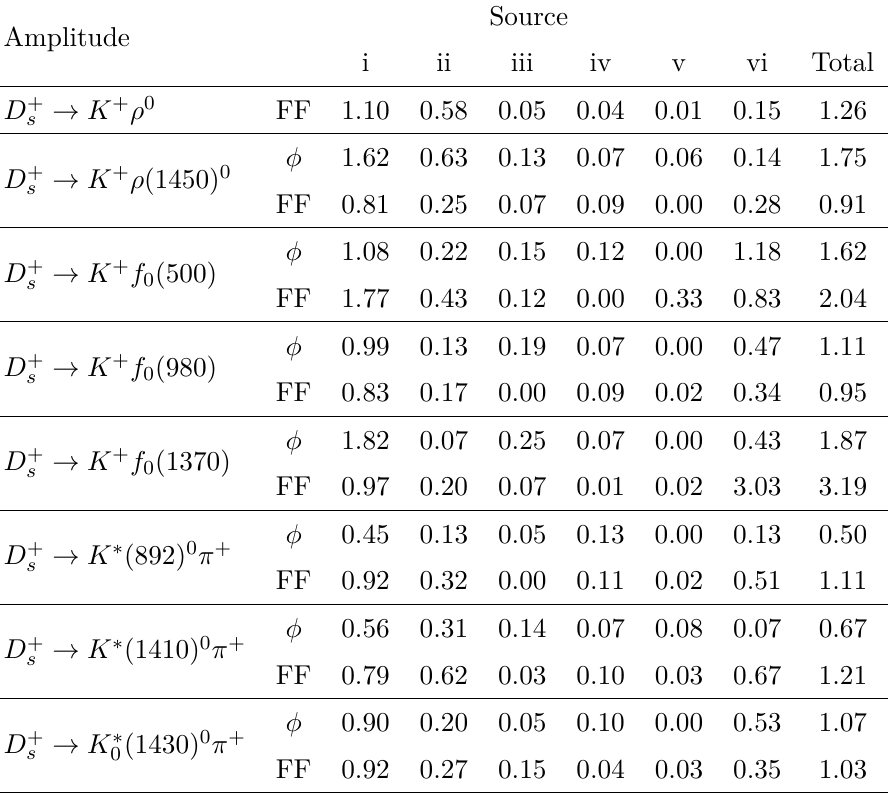
Table 8 . Systematic uncertainties on the φ and FF for each amplitude in units of the corresponding statistical uncertainty. The sources are: (i) fixed parameters in the amplitudes, (ii) R values, (iii) fit bias, (iv) background estimation, (v) experiment effects, (vi) insignificant